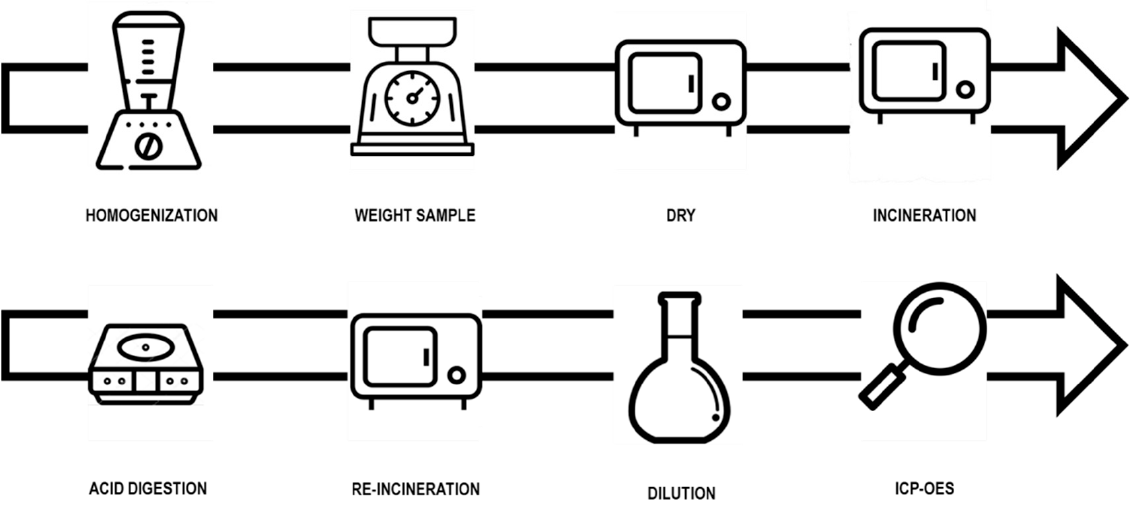
Figure 1. Sample treatment and analysis.